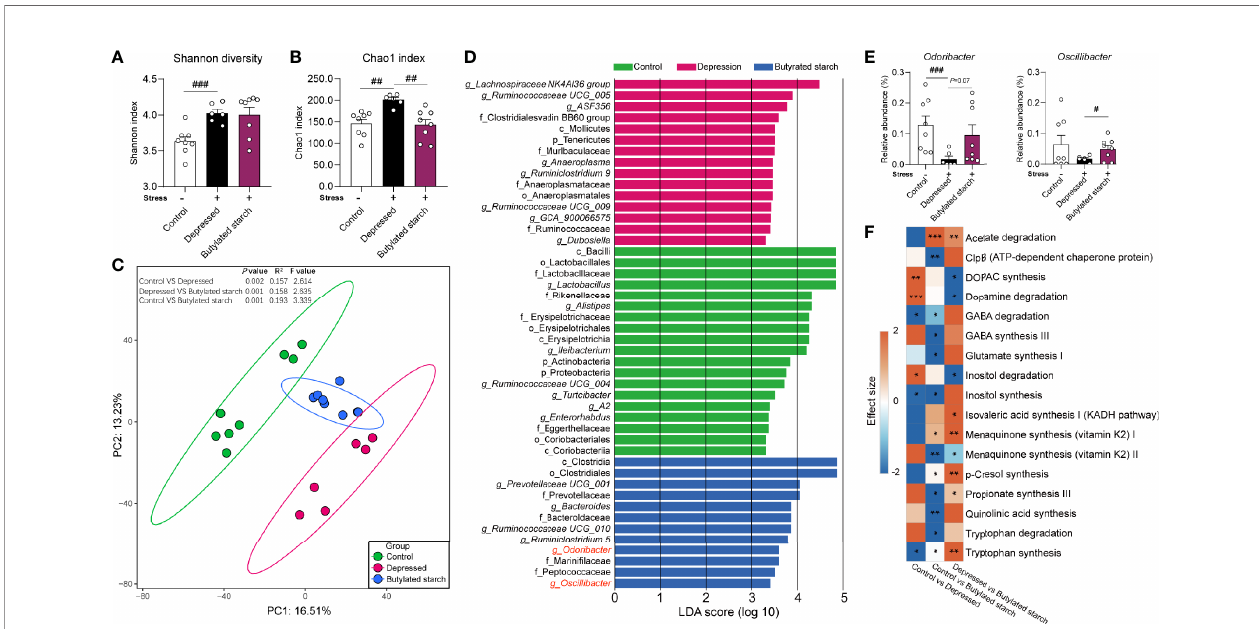
FIGURE 4 | The SCFAs levels in the ileum and cecum. (A, B) Alpha diversity of the gut microbiome, quanti fi ed using the Shannon and Chao 1 index. Except for the control, all groups are given two-week chronic restraint stress. Data are mean with SEM (n=6-10 per group). ## P <0.01, ### P <0.001 in the unpaired t-tests. (C) Beta diversity of the gut microbiome. PCA based on the center-log ratio transferred Aitchison distance followed by the PERMANOVA. (D) Microbial biomarkers are identi fi ed by the linear discriminant analysis (LDA) effect size algorithm (LEfSe). a <0.05 in the Wilcoxon rank-sum test and log LDA>2.0 were used as the threshold. (E) Relative abundance of selected microbes. Data are mean with SEM (n=6-10 per group). # P <0.05, ### P <0.001 in the unpaired t-tests. (F) Gut-brain module analysis. The colors of the boxes indicate the effect size between the two groups. Welch ’ s t-test was performed between two groups. Asterisks in the heat map represent the Benjamini-Hochberg false discovery rate (FDR)-adjusted p-value: * P <0.05, ** P <0.01, *** P<